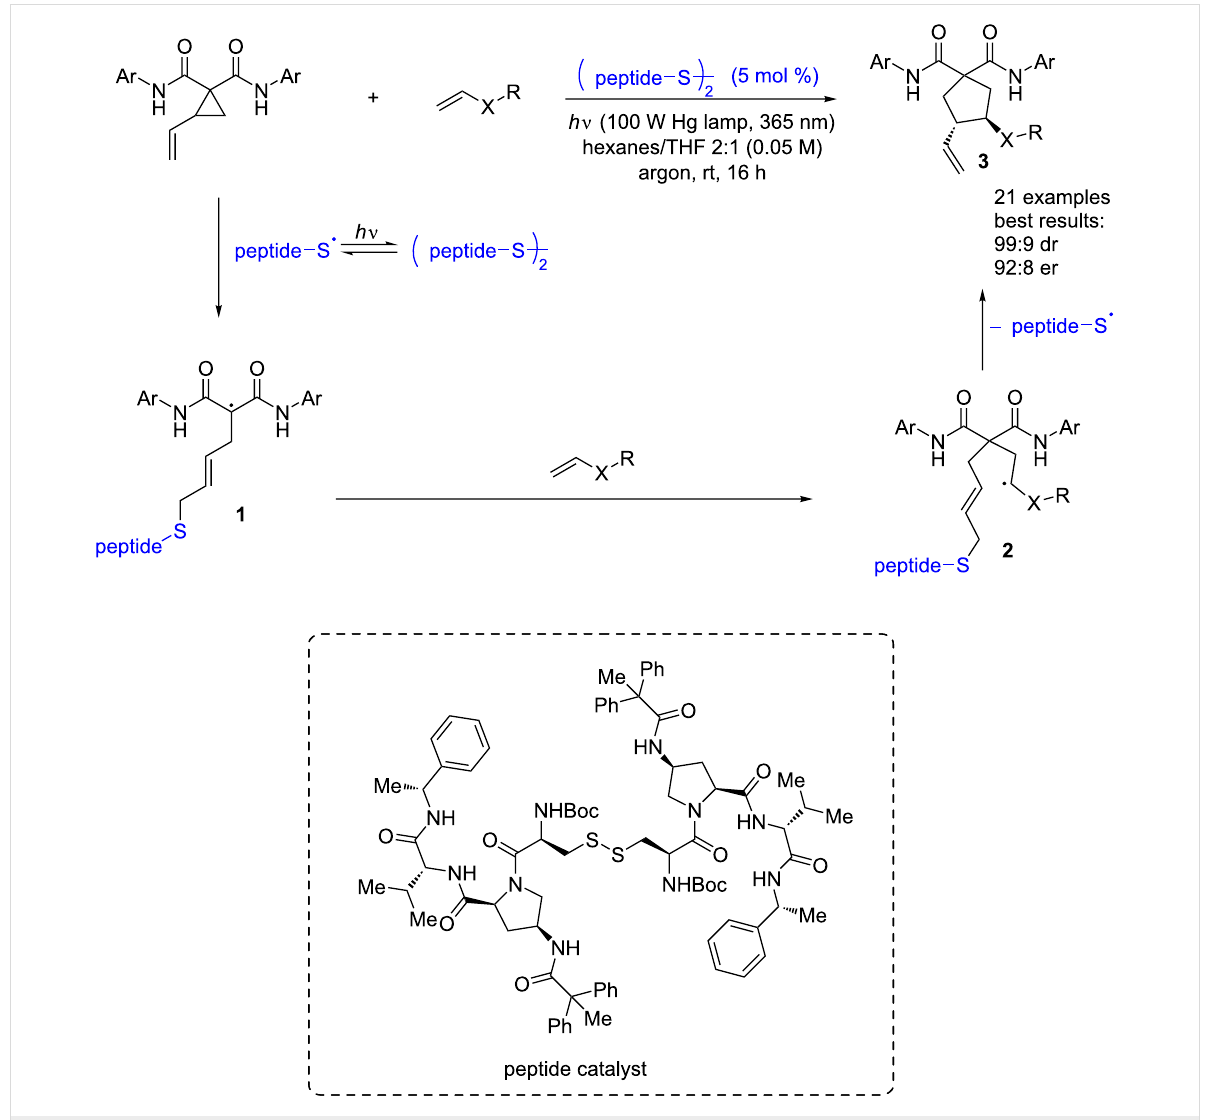
Scheme 3: Disulfide-bridged peptide-catalyzed enantioselective